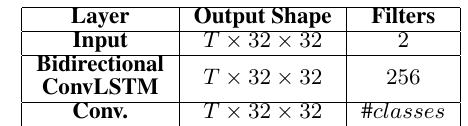
Table 2. BConvLSTM parameter configuration - T is the sequence length.